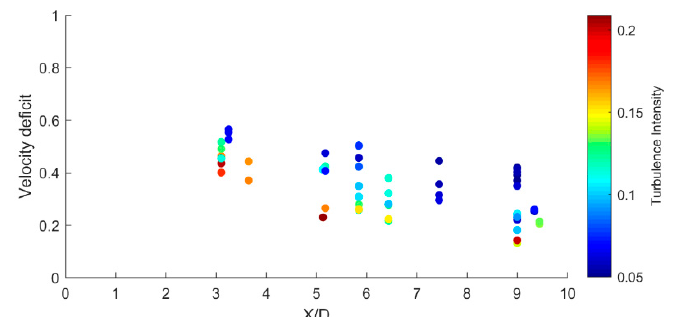
Figure 2. Supervisory Control And Data Acquisition (SCADA) data of velocity deficit based on paired turbines.